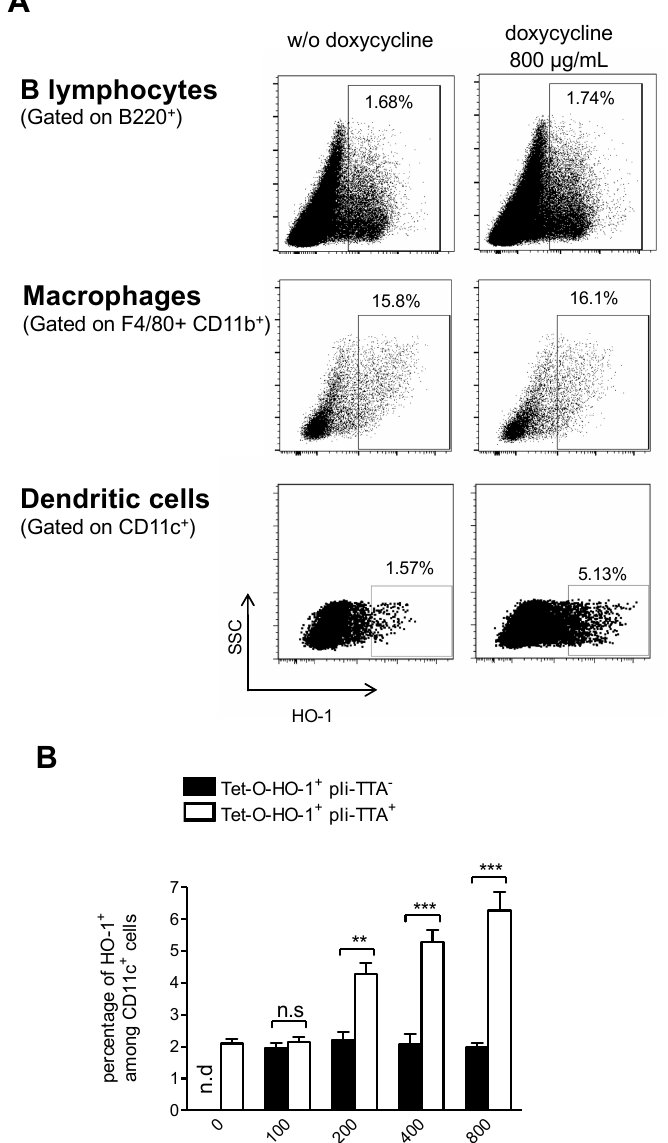
Figure 3. Induction of HO-1 expression by addition of doxycycline in the drinking water of double transgenic TetO-HO-1 + pIi-tTA + NOD mice. ( A , B ) Different doses of doxycycline (DOX) were added to the drinking water in single transgenic Tet-O-HO-1 + pli-tTA − or double transgenic TetO-HO-1 + pIi-tTA + NOD mice to induce HO-1 expression. ( A ) Splenic cell populations (DCs cells, B lymphocyte or